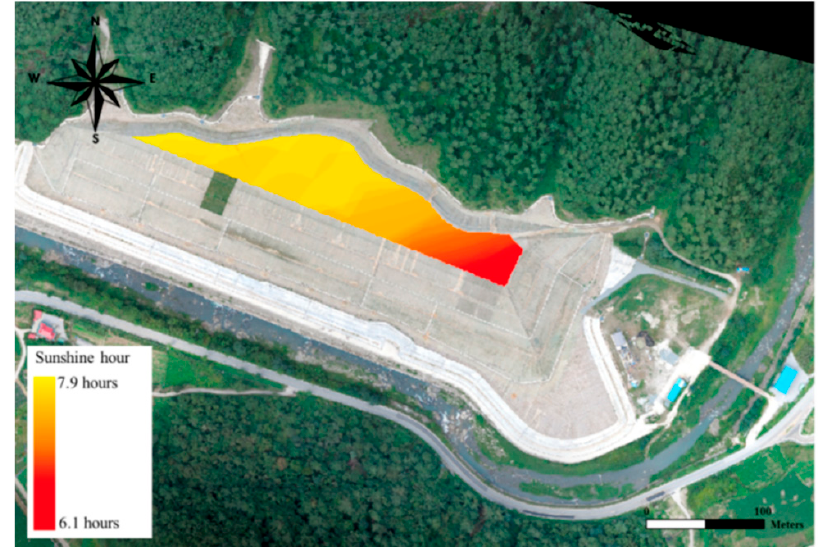
Figure 9. Daily sunshine hours on the surface of the tailing embankment on the winter solstice (Choi and Song [79]).